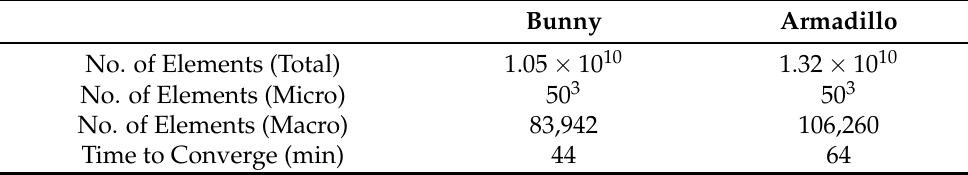
Table 6. Resolution and convergence time of the proposed framework in two